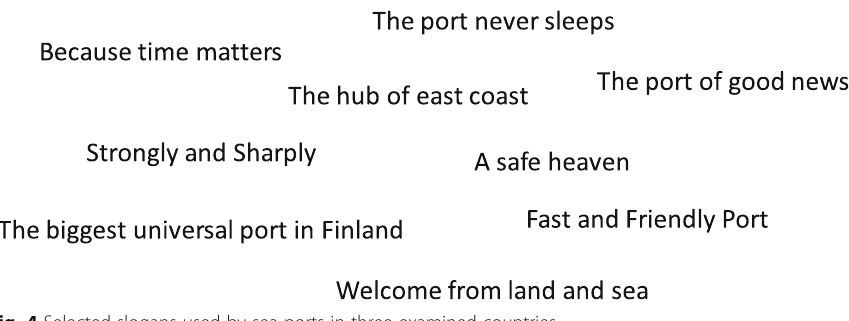
Fig. 4 Selected slogans used by sea ports in three examined countries